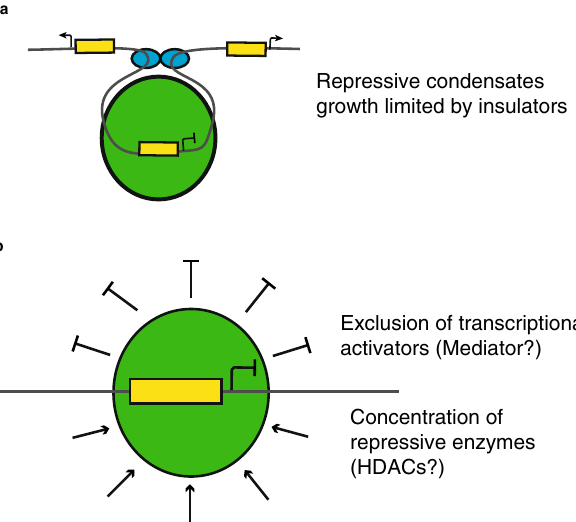
Fig. 7 The properties of repression condensates. a This schematic depicts a Hes.a repression condensate (Green circle) bound to an enhancer (yellow block) DNA and silencing the appropriate gene. The growth of this condensate is limited by the presence of paired insulators (blue ovals). A consequence of this is that the repression condensate cannot spread to inappropriately silence the neighboring genes. b A proposed mechanism for how repression condensates can function based on the exclusion of transcriptional activators as well as creating a high concentration of enzymes known to be involved in transcriptional repression such as